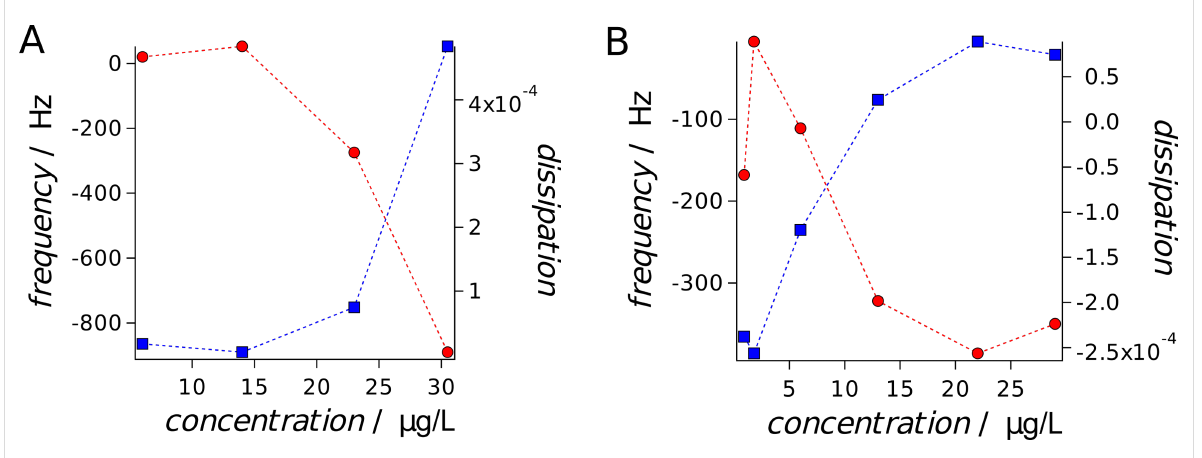
Figure 6: Equilibrium frequency and dissipation change (after 24 h of incubation) of a confluent MDCK II cell monolayer cultured on a 5 MHz quartz (fundamental frequency) as a function of CTAB-coated gold nanorod (A) and CTAB-cated gold nanosphere (B) concentration.